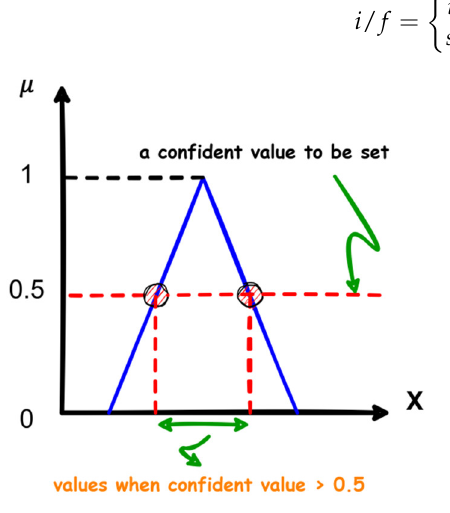
Figure 8. A confident value set on a neutrosophic set.